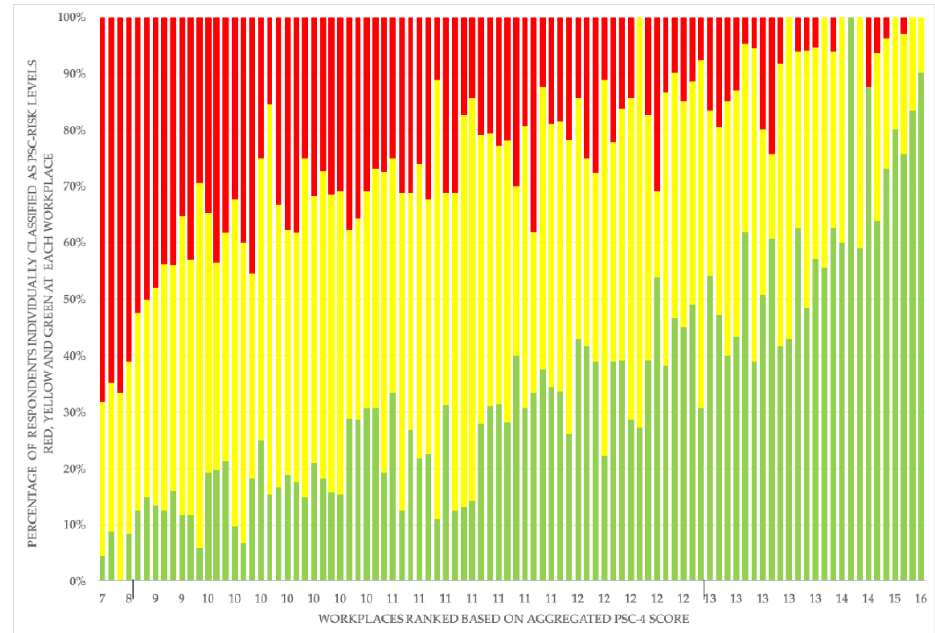
Figure 1. PSC-4 score aggregated to workplace level ( X -axis) by percentage of respondents at the